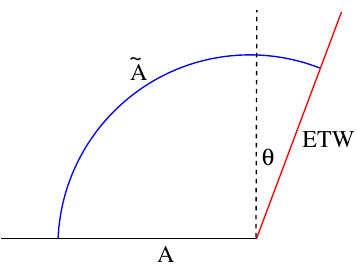
Figure 2 . Holographic calculation of entanglement entropy for an interval A containing the bound- ary. The RT surface ˜ A sits at a fixed location on the AdS 2 fibers of the dual geometry. Here A is homologous to ˜ A since the ETW brane represents a smooth part of full microscopic